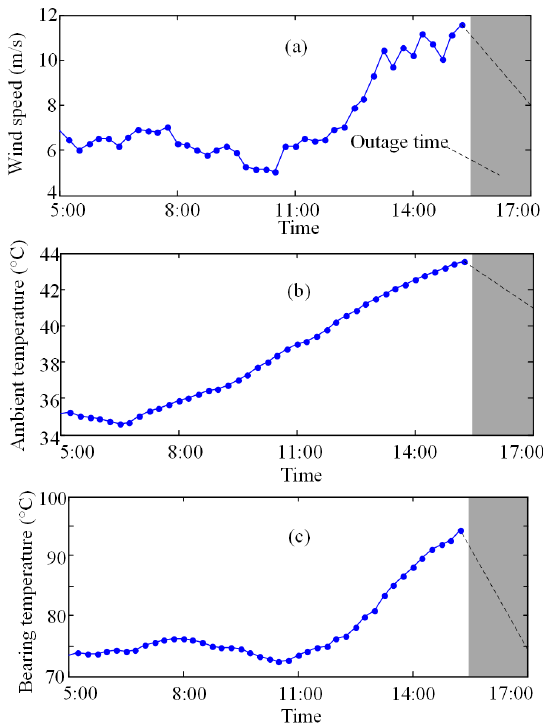
Figure 15. Time series of ( a ) wind speed; ( b ) Ambient temperature; and ( c ) Generator bearing b temperature. Figure 15. Timeseries of( a ) windspeed; ( b )Ambient temperature; and( c )Generator bearing b temperature. Table 6. Prediction results of wind speed. Table 6. Prediction results of wind speed.